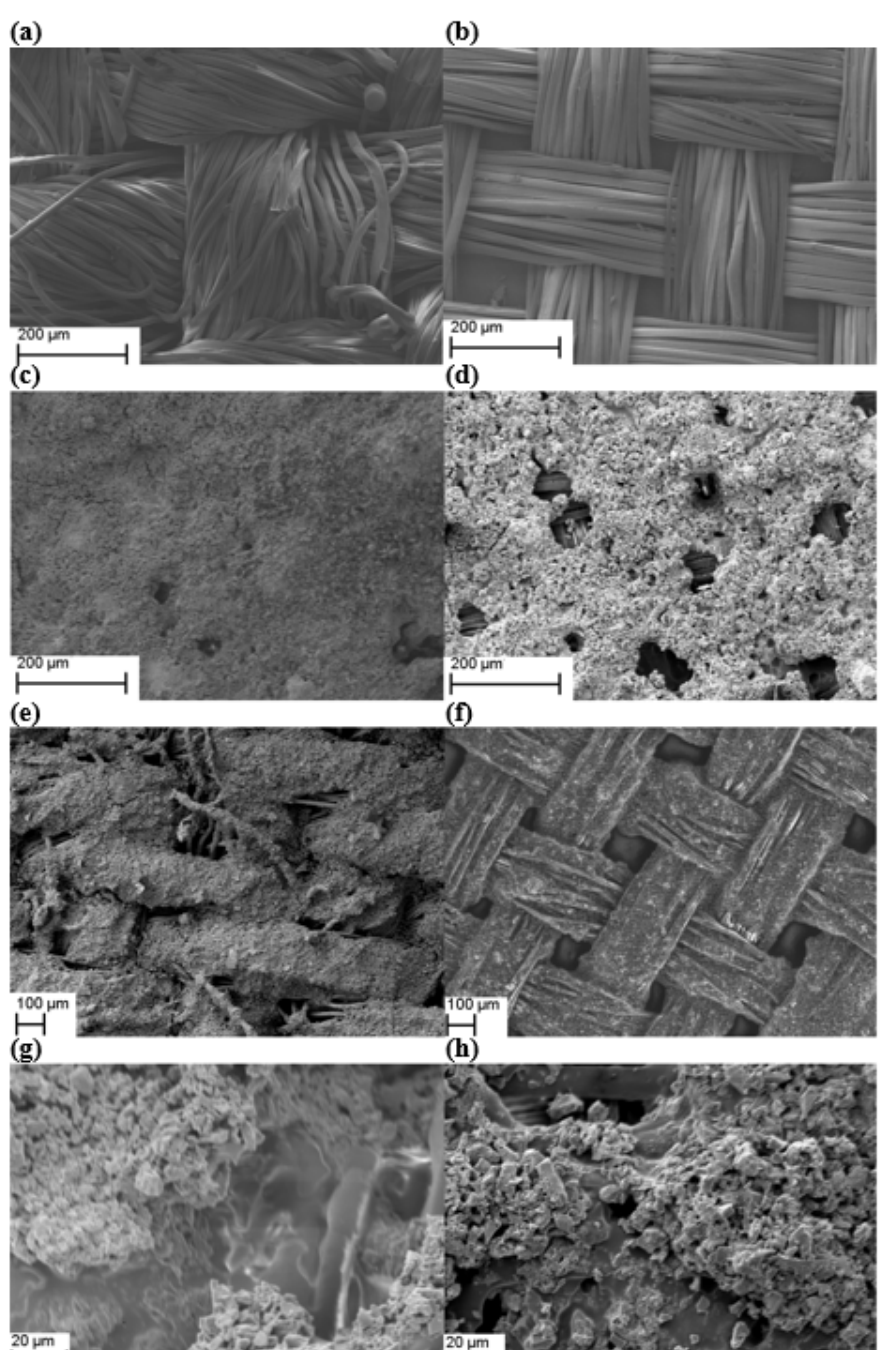
Figure 2. SEM photos showing plan views of ( a ) PC textile, ( b ) S textile, ( c ) PC textile with membrane and carbon coating, ( d ) S textile with membrane and carbon coating, ( e ) PC textile with carbon coating without membrane, ( f ) S textile with carbon coating without membrane, ( g ) PC textile with membrane and carbon coating (high magnification) and ( h ) S textile with membrane and carbon coating (high